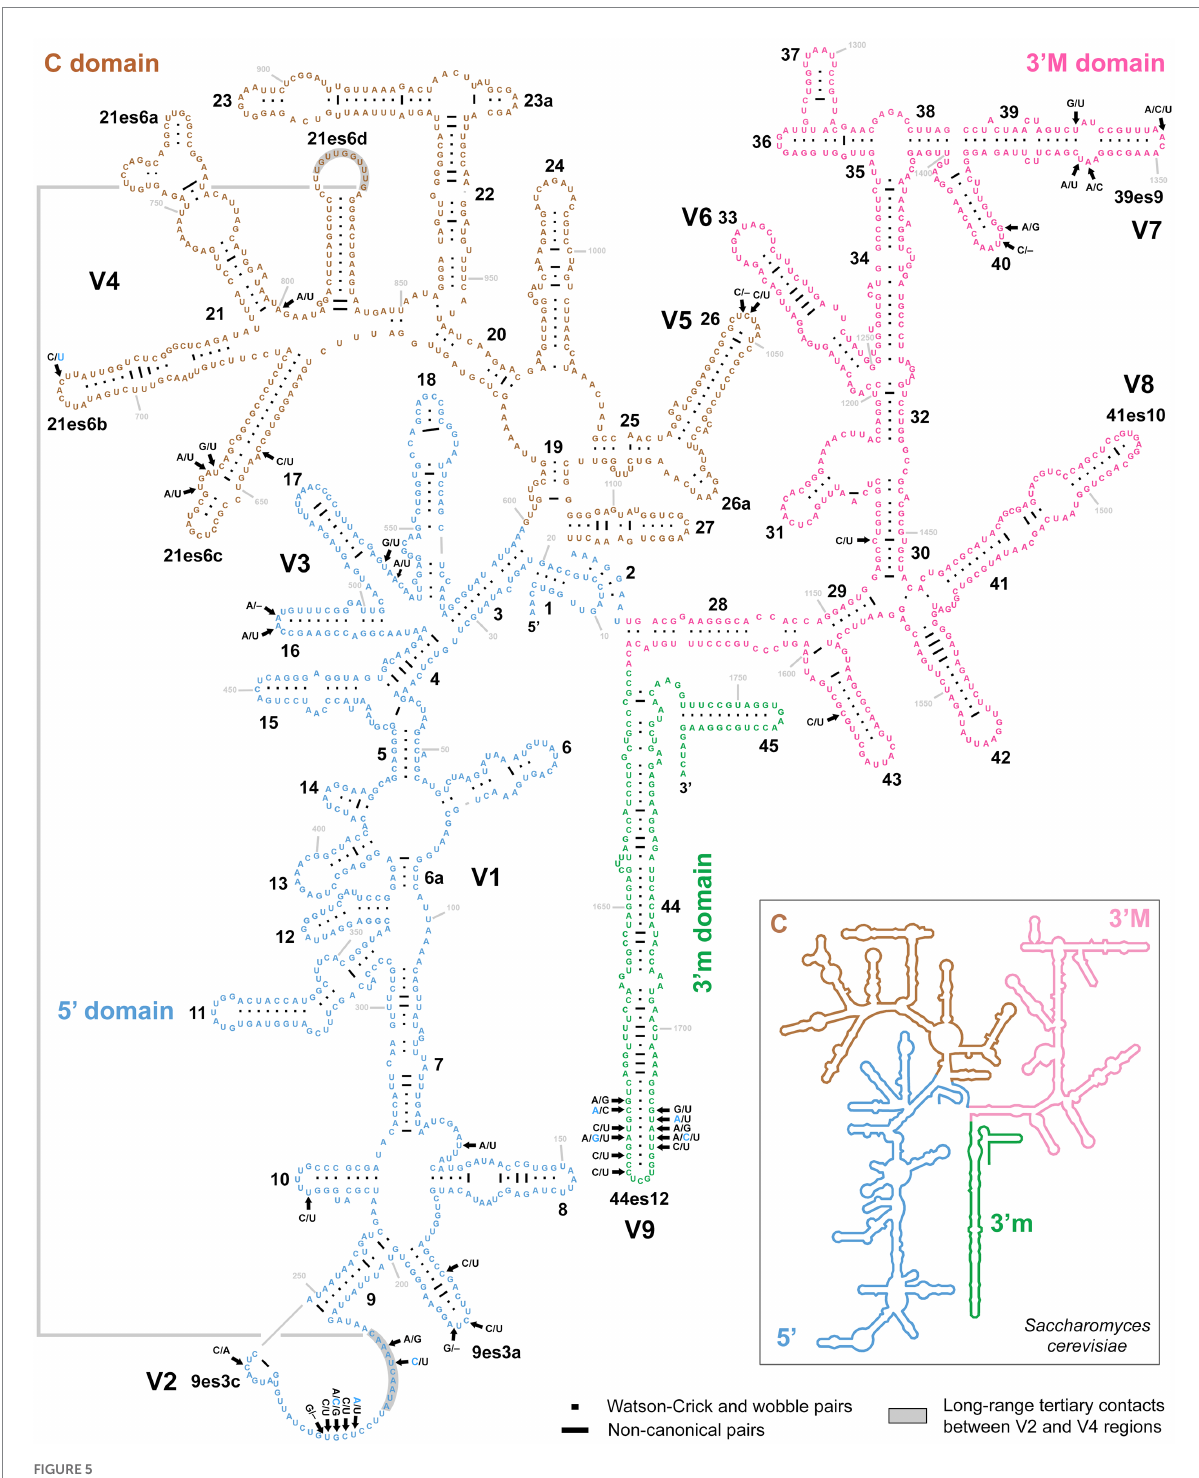
FIGURE 5 Secondary structure of the 18S rRNA molecule of specimen PUz 38 LT from the P. lumbrici complex. Variable nucleotide positions are marked by thick arrows and diagnostic molecular autapomorphies of P. aporrectodeae sp. n. are denoted by blue color. Variable nucleotide positions were localized in the V2–V5, V7, and V9 regions of the 18S rRNA molecule. Mutations tended to become accumulated in the single-stranded region of V2 and the double-stranded region of helix 44es12 of V9. There were as many as 42 polymorphic positions, whereas 13 were situated in terminal loops of helices, six in bulges or adjacent positions, nine in single-stranded regions, and 14 in double-stranded regions. Note the two compensatory base changes in the V2 region involved in long-range tertiary contacts with helix 21es6d in the V4 region. The 18S secondary structure map of Saccharomyces cerevisiae (inset) is from